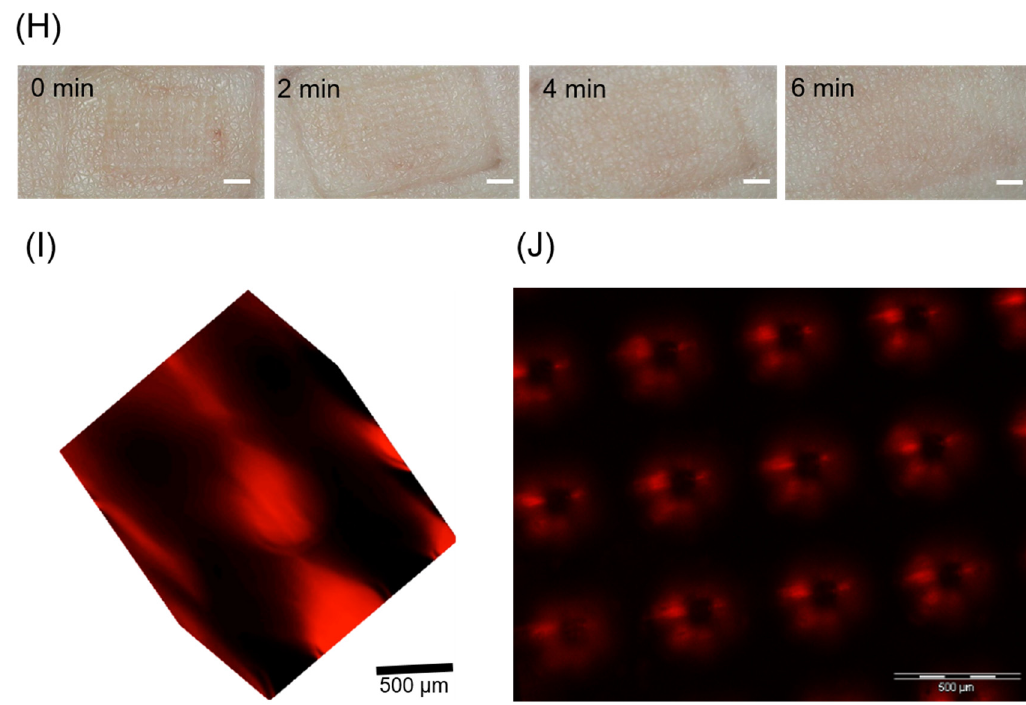
Figure 4. ( A ) Schematic diagram of compression test; ( B ) The force-displacement curves of cone or pyramid MN; ( C ) Pinhole image of mouse micro-skin after 30 s of pressing (scale bar: 2 mm); ( D ) Mouse skin peeled within 1 min after microneedle puncture (scale bar: 2 mm); ( E ) Trypan blue staining image of mouse skin administration (scale bar: 2 mm); ( F ) H&E-stained cross-section of inserted skin by MN; ( G ) SEM image of MN after application to the skin; ( H) Skin recovery images at 0 min, 2 min, 4 min and 6 min after MN treatment (scale bar: 2 mm); ( I ) Fluorescent confocal stereogram with FITC drug-loaded microneedles (scale bar: 500 μ m).; ( J ) Fluorescent confocal top view of FITC drug-loaded microneedles (scale bar: 500 µ m).